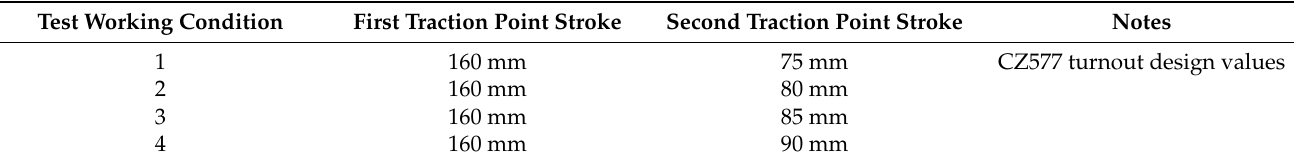
Table 1. Numerical test conditions.